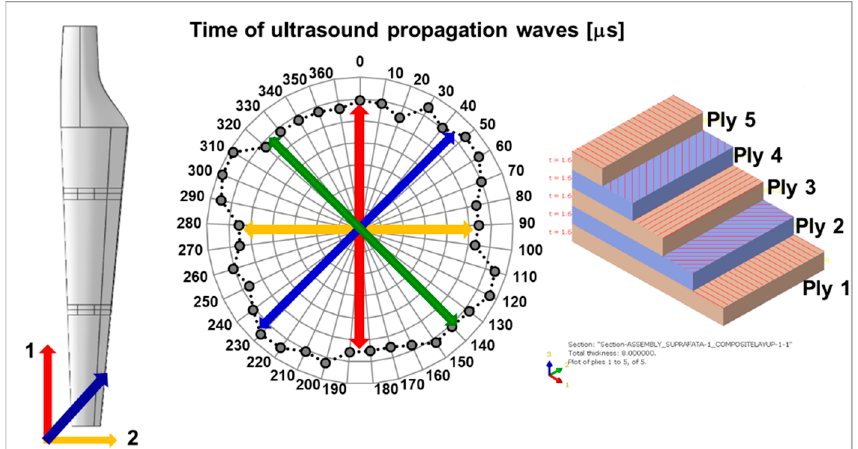
Figure 3. The variation of ultrasound propagation time in WTB composites in relation to the direction of composite layer orientation.